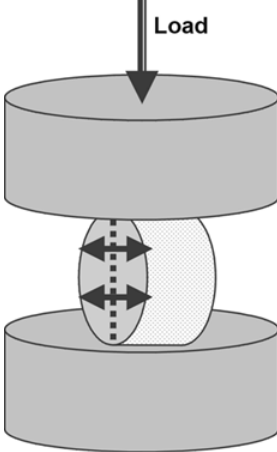
FIGURE 5- Schematic illustration of flexural strength test of a material